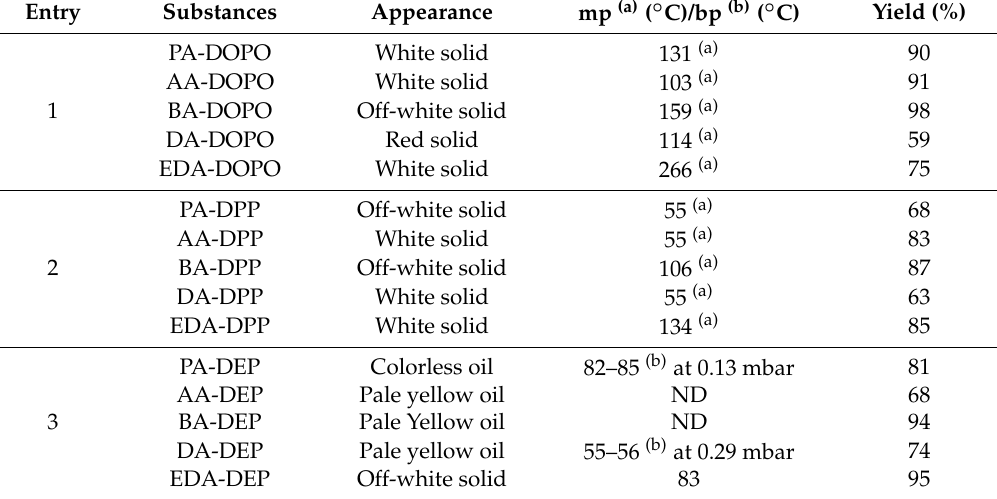
Table 3. Physical properties of the phosphonamidates and phosphoramidates.